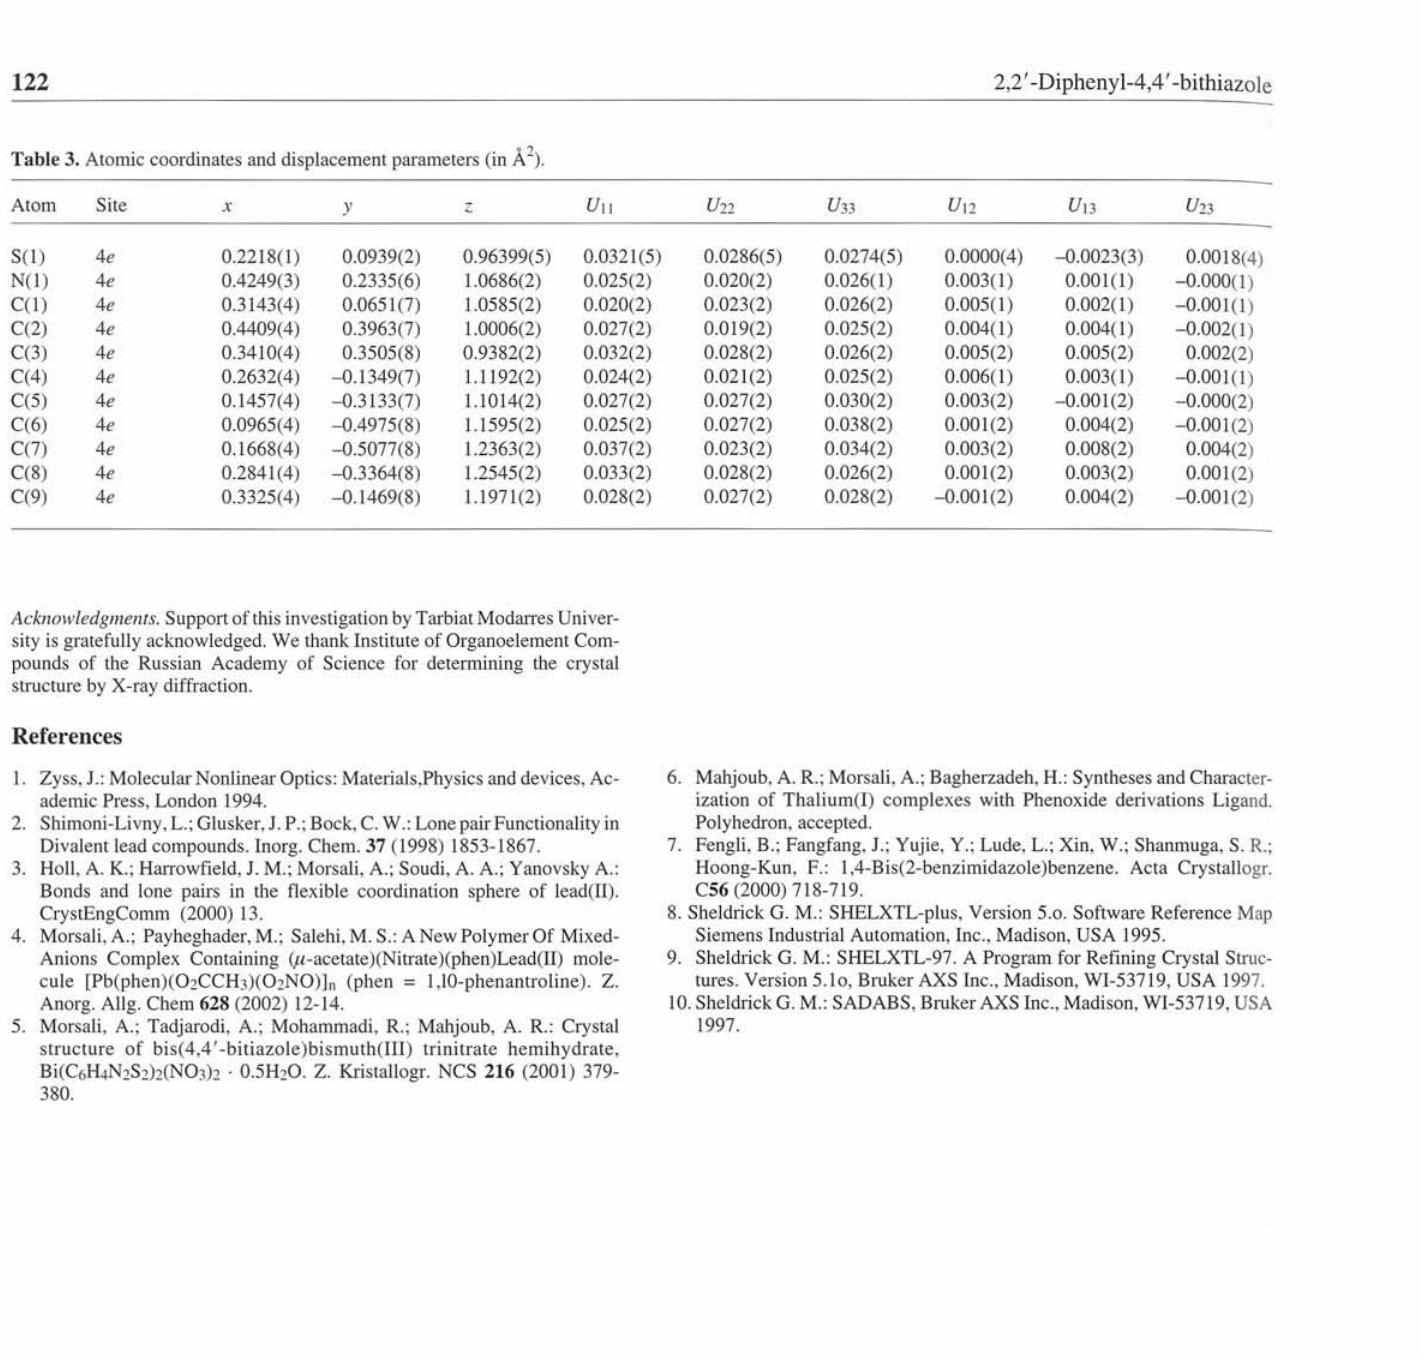
Table 3. Atomic coordinates and displacement parameters (in Â^).